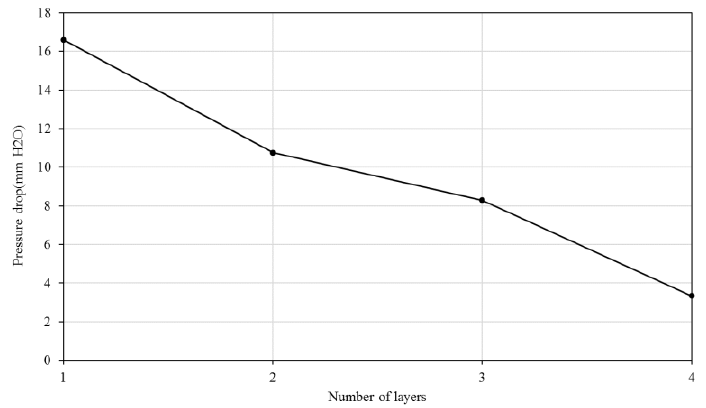
Figure 13. Effects of number of layers on the pressure drop across the heat sink of 30 mL/min HTF flow rate and 15 W power rate.